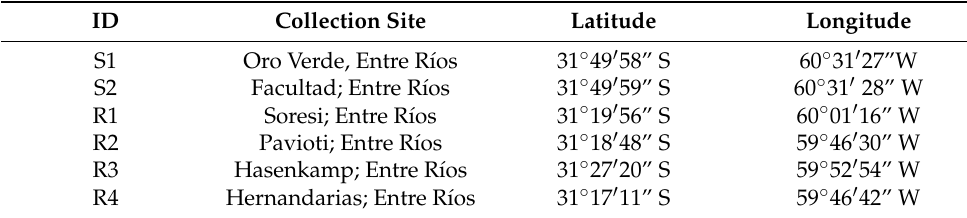
Table 4. Genotype sampling